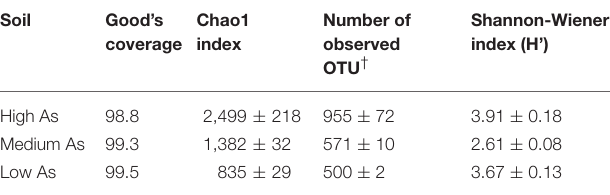
Frontiers in Microbiology |